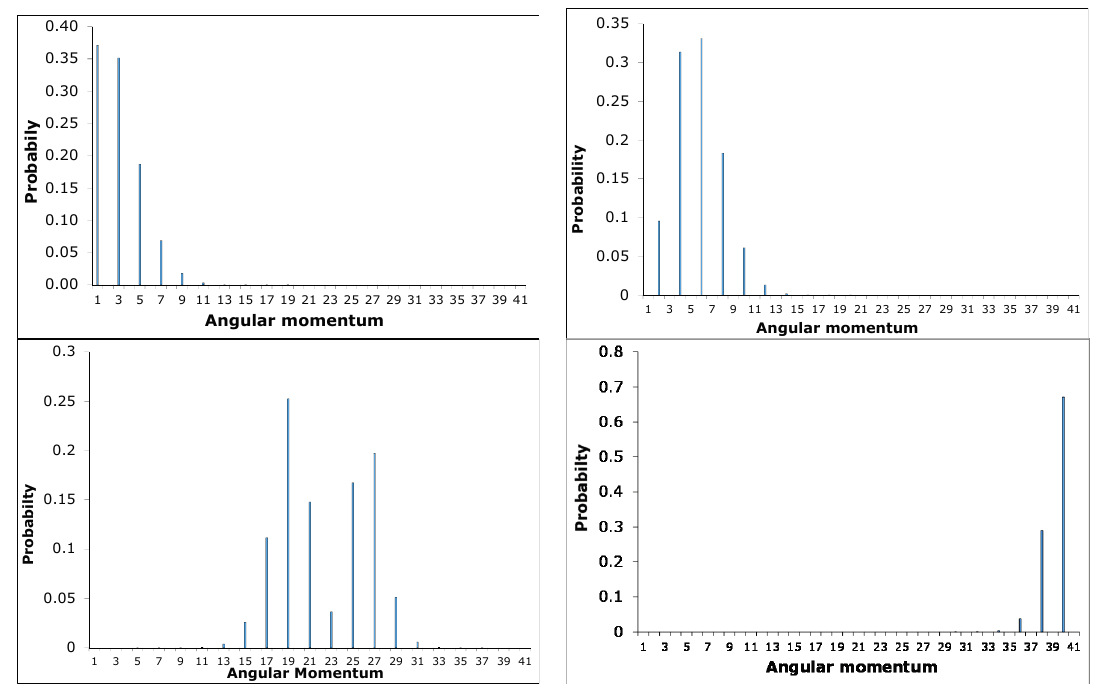
Figure 12. Probability distribution at m = 0 for a particle constrained to move on the surface of a “peanut” with ℓ = 0 − 40 .